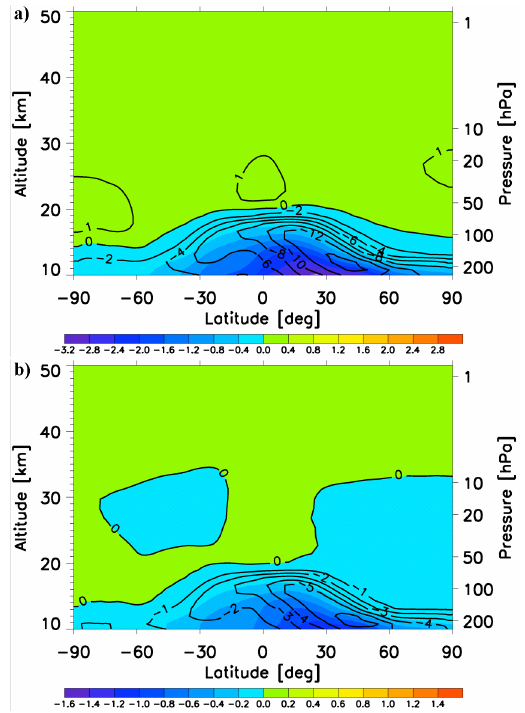
Figure 9. Annually, zonally averaged HO x concentration changes in units of 10 6 molecules cm -3 (shown by color) and the relative change in % (shown by contours) in the H 2 -ICE scenarios compared with the BL scenarios as a function of latitude and altitude for (a) A1FI and (b) B1 scenarios.